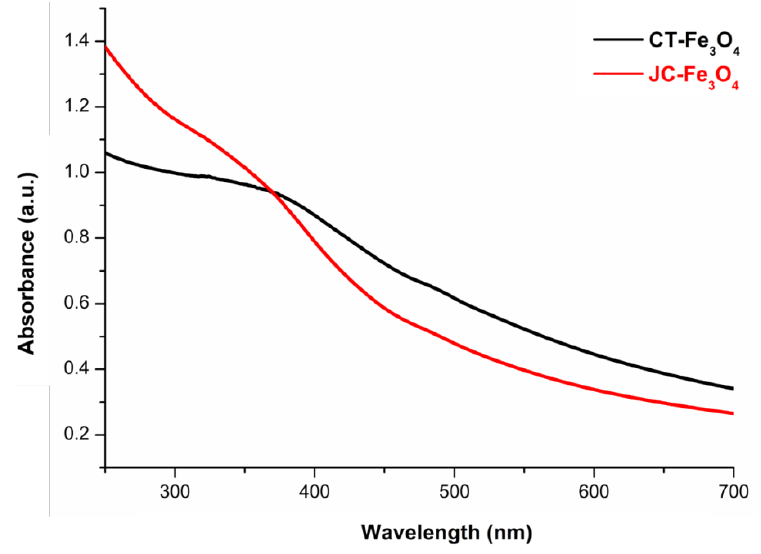
Figure 2. UV-Vis absorption spectra of CT-Fe 3 O 4 and JC-Fe 3 O 4 NPs.